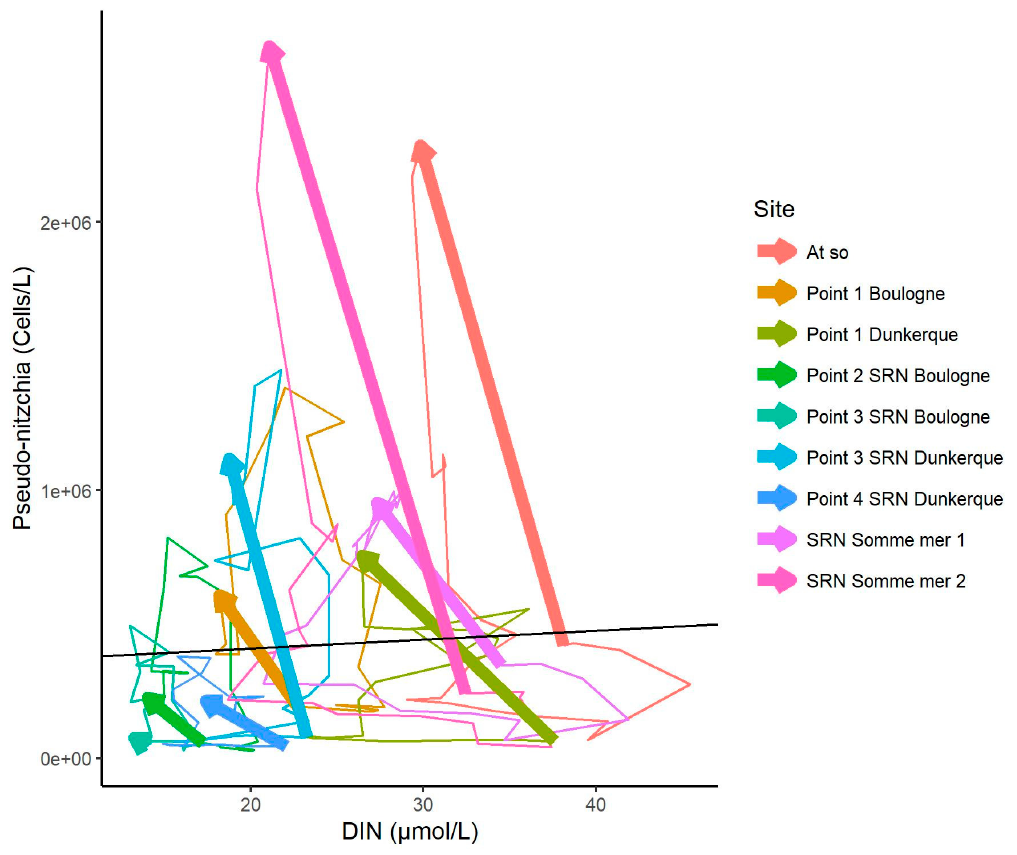
Figure A6. Temporal trajectories of the relationship between Pseudo-nitzchia and Dissolved Inorganic Nitrogen (DIN) concentrations by site and by period (six-year sliding periods between 1994 and 2018). The arrows indicate the overall trajectories (first period to last period). Complete trajectories are represented by thin colored lines.